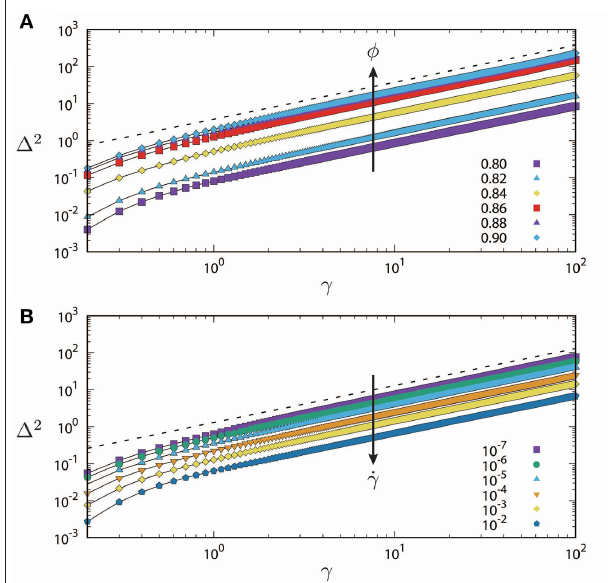
FIGURE 1 | Snapshots of our MD simulations, where the particles (circles) are sheared as indicated by the horizontal arrows in (A) . The filled (open) circles represent mobile (immobile) particles, where the magnitude of their non-affine velocities | v i − u ( r i ) | is larger (smaller) than 10 d 0 ˙ γ . The shear rate is ˙ γ = 10 − 7 t − 1 0 and the packing fraction φ increases as (A) 0.80, (B) 0.84, (C) 0.85, and (D) 0.90.